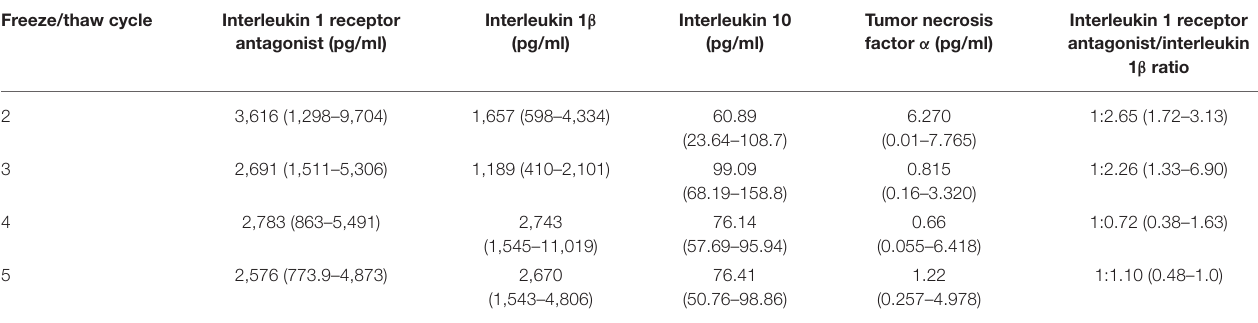
TABLE 4 | Median (interquartile range) concentrations of cytokines measured for each freeze/thaw cycle. Freeze/thaw